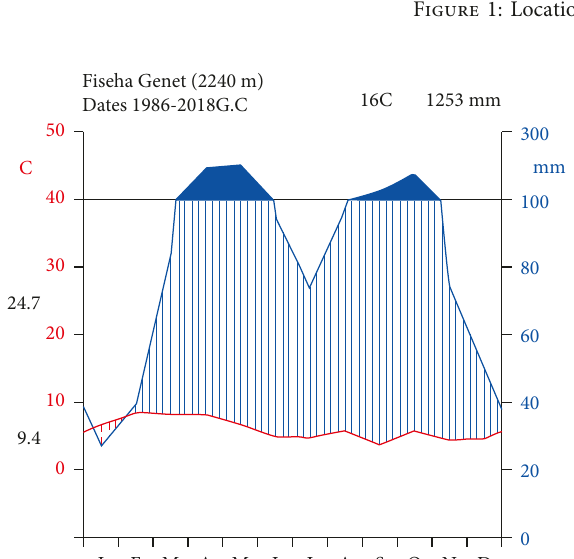
Figure 1: Location map of the study area.